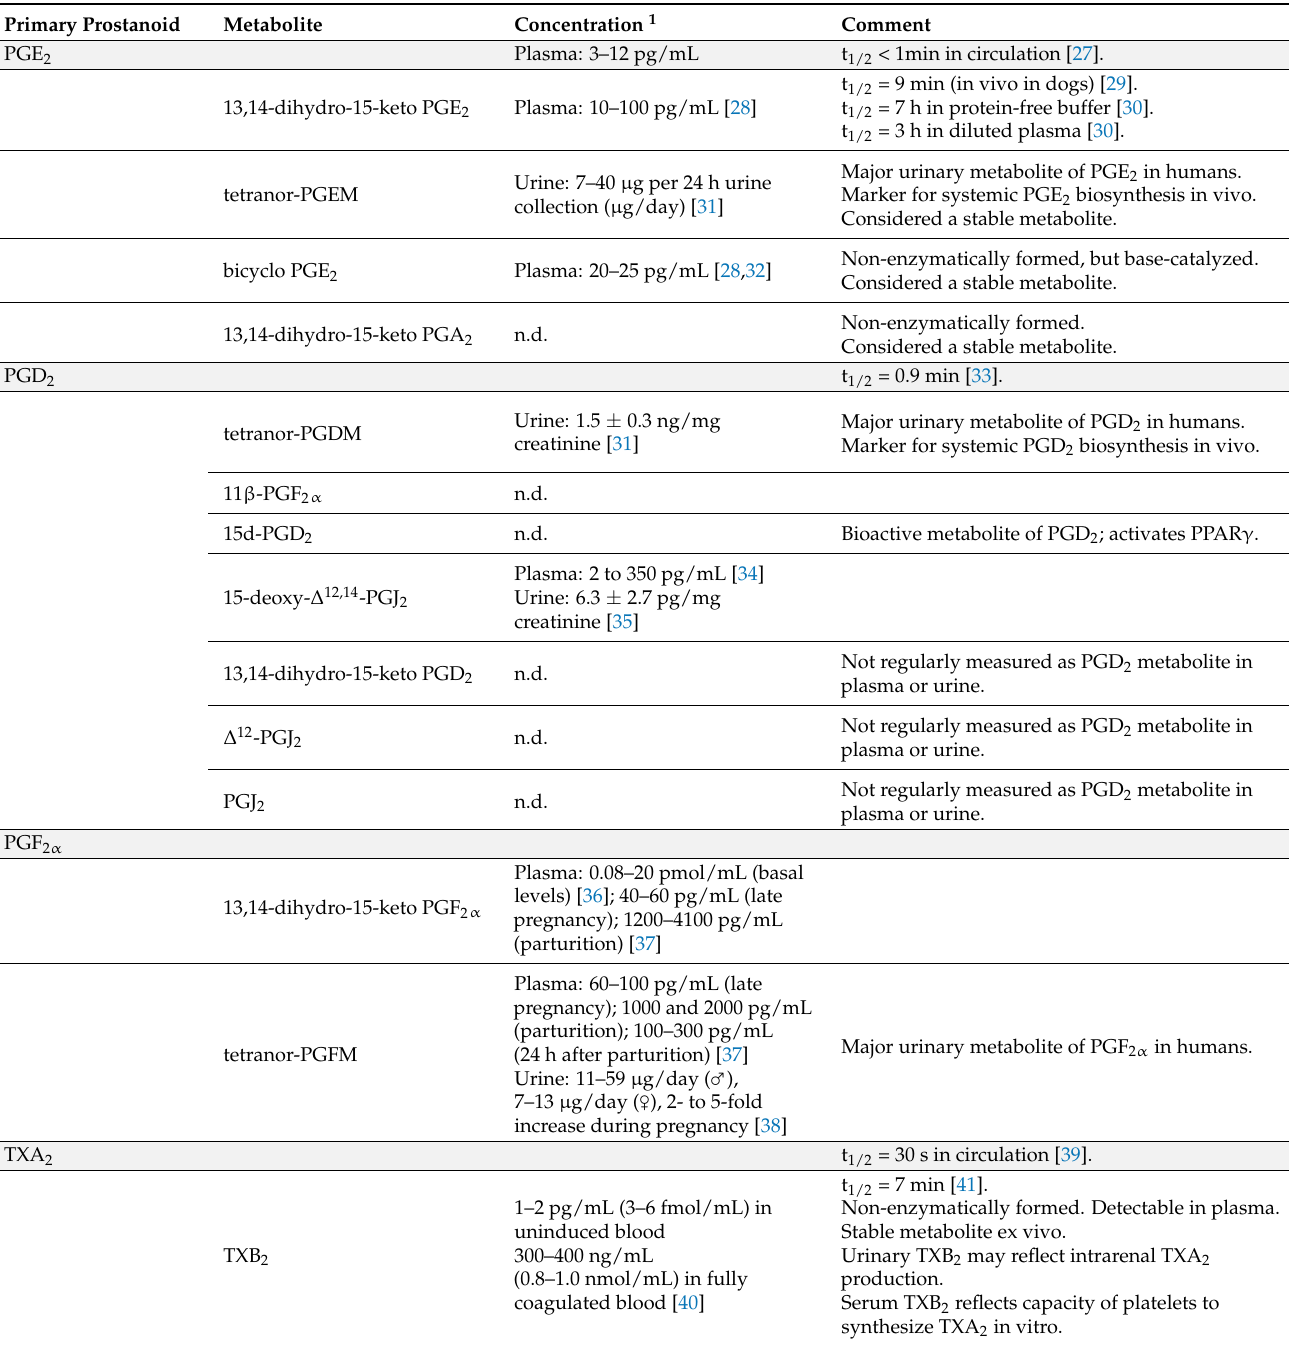
Table 1. Prostanoid metabolites and their concentrations in